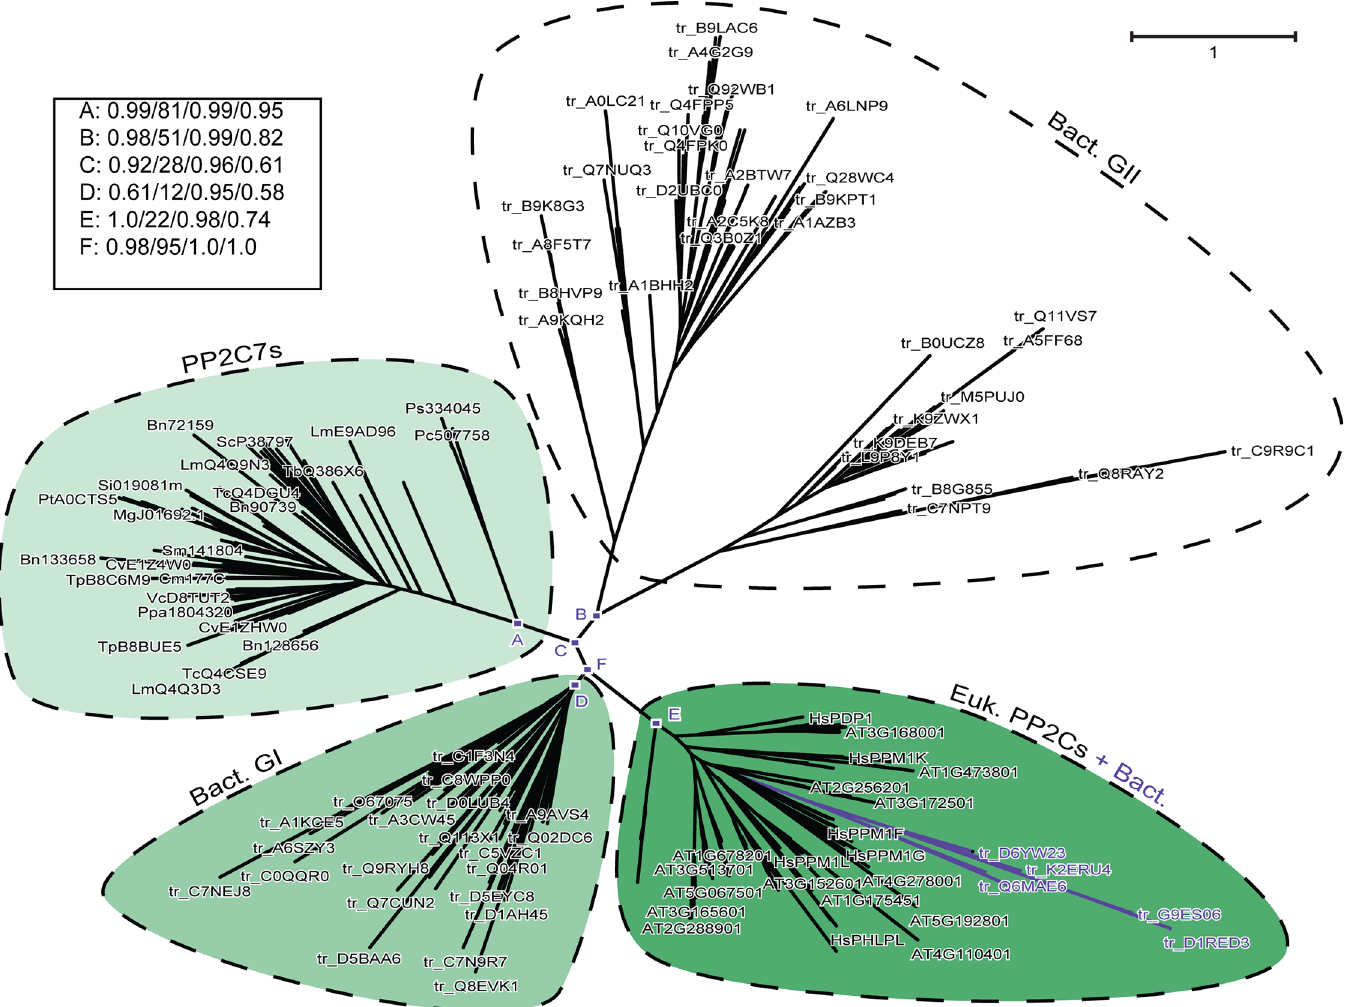
Fig 6. Phylogenetic radial tree depicting a large scale comparison between PP2C7 sequences, bacterial Group II sequences, bacterial Group I sequences and eukaryotic PP2C sequences. There are 102 representative PP2C7 sequences, and 49 representative bacterial Group I sequences. The eukaryotic PP2C set consists of the combined sequences (excluding PP2C7s) from Arabidopsis and human (96 sequences total — HsTAB1 excluded). The bacterial Group II sequences include representatives from both “ Bulk ” (50 sequences) and “ GN ” types (38 sequences) (see text for explanation of sequence varieties). There are also 9 “ Eukaryotic-Like ” bacterial PP2C sequences (see text for explanation). Inference of unrooted phylogenetic trees was performed as outlined in “ Materials and Methods. ” The most crucial nodes are labeled. Node support values with the four inference methods (PhyML [aBayes], RAxML [RBS], MrBayes [PP], and PhyloBayes_MPI [PP]) are tabulated in the Figure, separated by slashes ( “ / ” ). Support values for all trees are summarized in Table N in S1 File. The cluster of “ Eukaryotic-Like ” bacterial PP2C sequences within the eukaryotic PP2C clade is indicated by colored lines. This tree is based on the amino acid sequence alignment presented in Fig A in S2 File, Panel